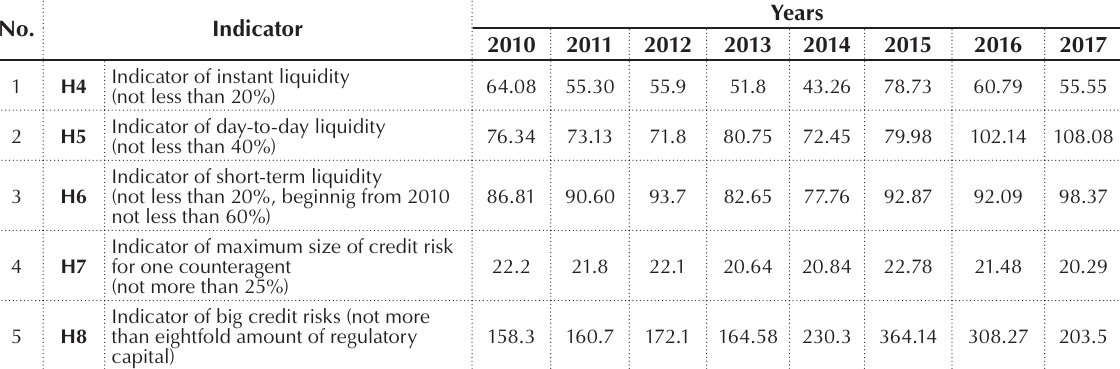
Table (cid:1006). (cid:24)(cid:455)(cid:374)(cid:258)(cid:373)(cid:349)(cid:272)(cid:400)(cid:3)(cid:381)(cid:296)(cid:3)(cid:448)(cid:258)(cid:367)(cid:437)(cid:286)(cid:400)(cid:3)(cid:381)(cid:296)(cid:3)(cid:286)(cid:272)(cid:381)(cid:374)(cid:381)(cid:373)(cid:349)(cid:272)(cid:3)(cid:349)(cid:374)(cid:282)(cid:349)(cid:272)(cid:258)(cid:410)(cid:381)(cid:396)(cid:400)(cid:3)(cid:271)(cid:258)(cid:400)(cid:286)(cid:282)(cid:3)(cid:381)(cid:374)(cid:3)(cid:410)(cid:346)(cid:286)(cid:3)(cid:400)(cid:455)(cid:400)(cid:410)(cid:286)(cid:373)(cid:853)(cid:3)(cid:1006)(cid:1004)(cid:1005)(cid:1004)(cid:884)(cid:1006)(cid:1004)(cid:1005)(cid:1011)(cid:3) (cid:94)(cid:381)(cid:437)(cid:396)(cid:272)(cid:286)(cid:855)(cid:3)C(cid:381)(cid:373)(cid:393)(cid:349)(cid:367)(cid:286)(cid:282)(cid:3)(cid:271)(cid:455)(cid:3)(cid:410)(cid:346)(cid:286)(cid:3)(cid:258)(cid:437)(cid:410)(cid:346)(cid:381)(cid:396)(cid:400)(cid:3)(cid:381)(cid:374)(cid:3)(cid:410)(cid:346)(cid:286)(cid:3)(cid:271)(cid:258)(cid:400)(cid:349)(cid:400)(cid:3)(cid:381)(cid:296)(cid:3)(cid:400)(cid:410)(cid:258)(cid:410)(cid:349)(cid:400)(cid:410)(cid:349)(cid:272)(cid:3)(cid:349)(cid:374)(cid:296)(cid:381)(cid:396)(cid:373)(cid:258)(cid:410)(cid:349)(cid:381)(cid:374)(cid:3)(cid:381)(cid:296)(cid:3)(cid:410)(cid:346)(cid:286)(cid:3)(cid:69)(cid:258)(cid:410)(cid:349)(cid:381)(cid:374)(cid:258)(cid:367)(cid:3)(cid:17)(cid:258)(cid:374)(cid:364)(cid:3)(cid:381)(cid:296)(cid:3)(cid:104)(cid:364)(cid:396)(cid:258)(cid:349)(cid:374)(cid:286)(cid:3)((cid:286)(cid:454)(cid:272)(cid:367)(cid:437)(cid:282)(cid:349)(cid:374)(cid:336)(cid:3)(cid:349)(cid:374)(cid:400)(cid:381)(cid:367)(cid:448)(cid:286)(cid:374)(cid:410)(cid:3)(cid:271)(cid:258)(cid:374)(cid:364)(cid:400)(cid:895)(cid:856)